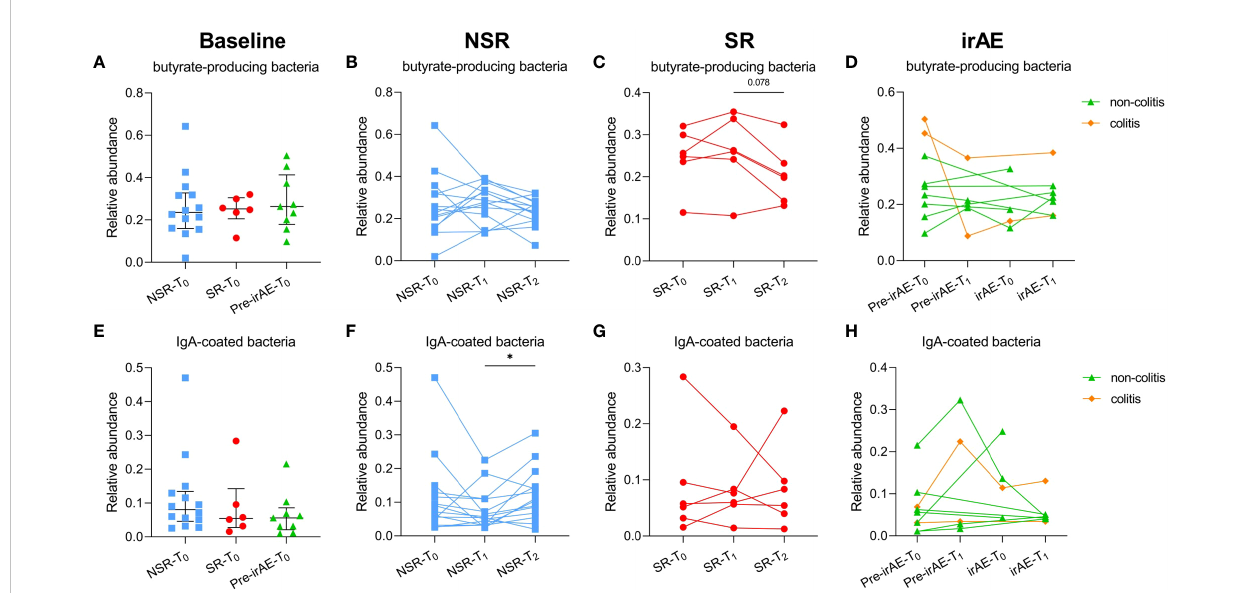
FIGURE 5 The relative abundance of butyrate-producing bacteria and IgA-coated bacteria in patients with/without secondary resistance and irAE occurrence. The relative abundance of baseline (A) and individual changes in butyrate-producing bacteria in NSR patients (B) , SR patients (C) , and irAE patients (D) ; the relative abundance of baseline (E) and individual changes in IgA-coated bacteria in NSR patients (F) , SR patients (G) , and irAE patients (H) . Medians and interquartile ranges are indicated. irAE, immune-related adverse event; NSR, non-secondary resistance; NSR-T 0 , non-secondary resistance patients - before ICI treatment; NSR-T 1 , non-secondary resistance patients - primary response after ICI treatment; NSR-T 2 , non- secondary resistance patients - durable response after ICI treatment; SR, secondary resistance; SR-T 0 , secondary resistance patients - before ICI treatment; SR-T 1 , secondary resistance patients - primary response after ICI treatment; SR-T 2 , secondary resistance patients - secondary resistance after ICI